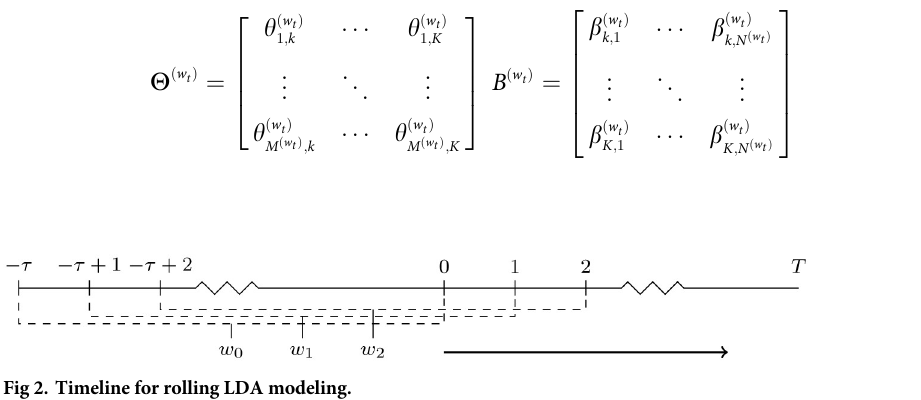
Fig 2. Timeline for rolling LDA